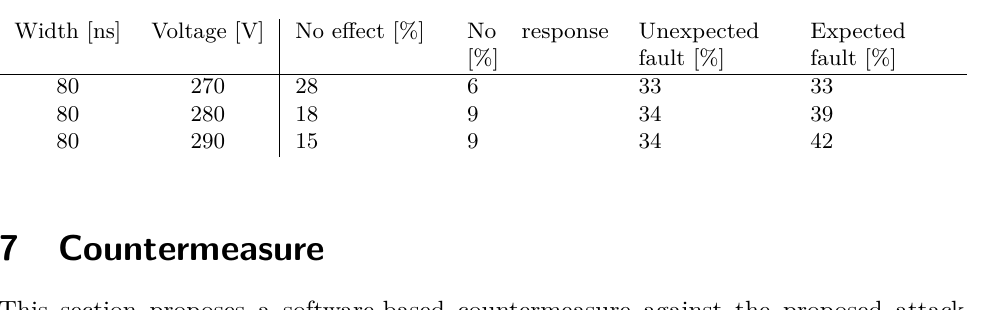
Figure 13: Relationship between glitch parameters and observed fault influences and their number of occurrence. Table 4: Fault intensity and probability of occurrence of each fault